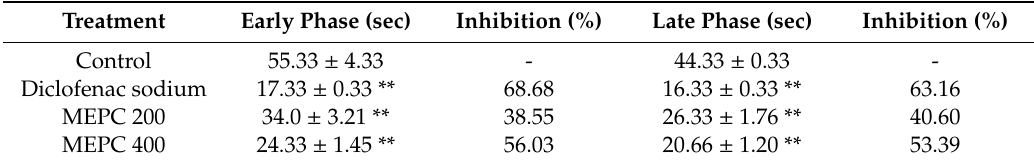
Figure 3. Antidepressant activity of methanol extract of P. calocarpa (MEPC) and fluoxetine on ( A ) forced swimming test and ( B ) tail suspension test. Values represented as mean ± SEM ( n = 5). ** p < 0.001 considered as significantly different from the control (Dunnett’s test). Table 1. Antinociceptive activity of methanol extract of P. calocarpa (MEPC) in formalin-induced licking test in